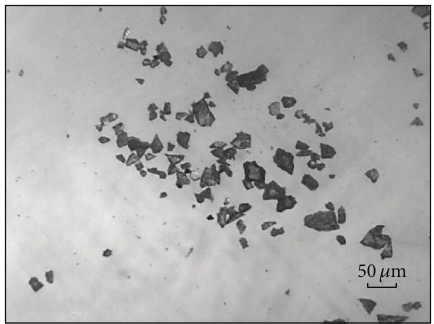
Figure 6: Sphalerite with no reagent treated.